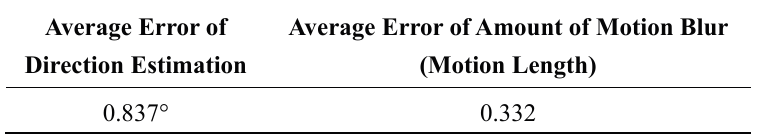
Table 11. Estimation errors of motion blur parameters using entire new motion blur database obtained from MORPH database.